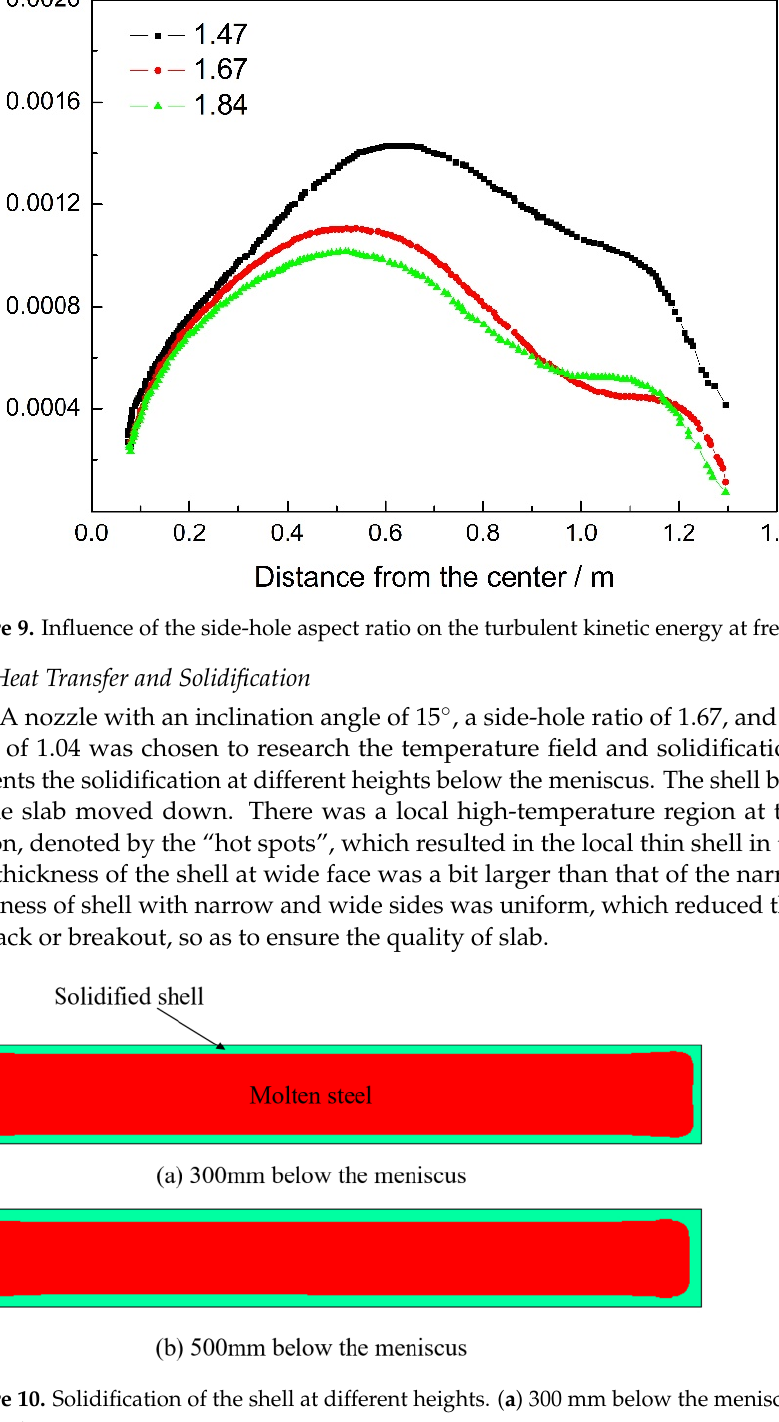
below the mm below the meniscus.